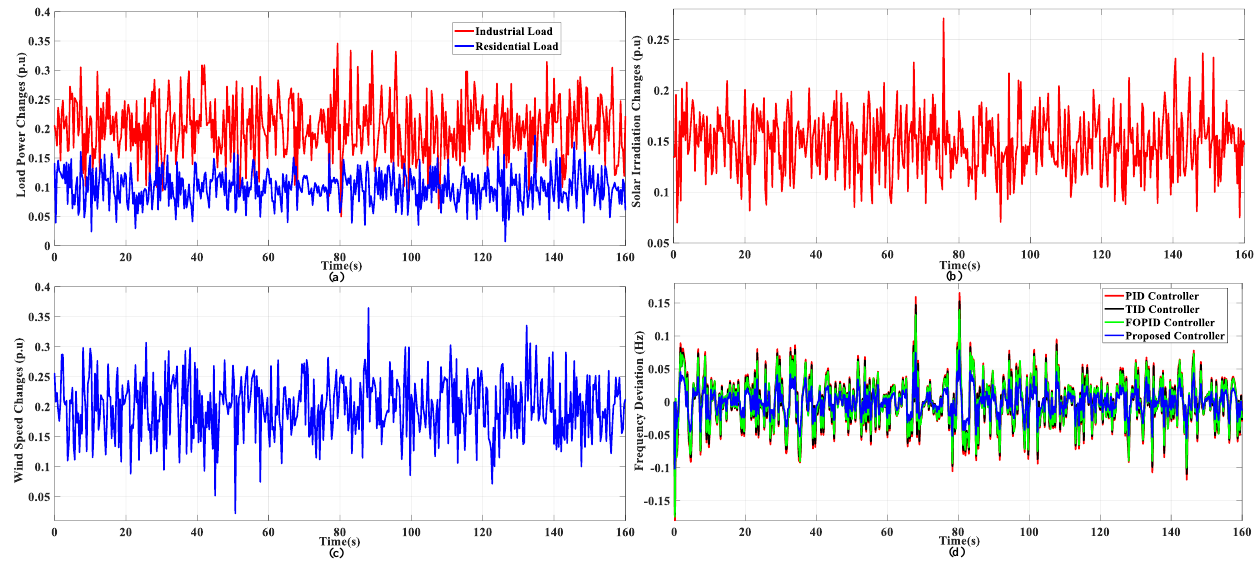
Figure 8. Perturbations and simulation result for scenario 4. ( a ) Load disturbances. ( b ) Wind speed changes. ( c ) Solar irradiation changes. ( d ) Obtained frequency responses.